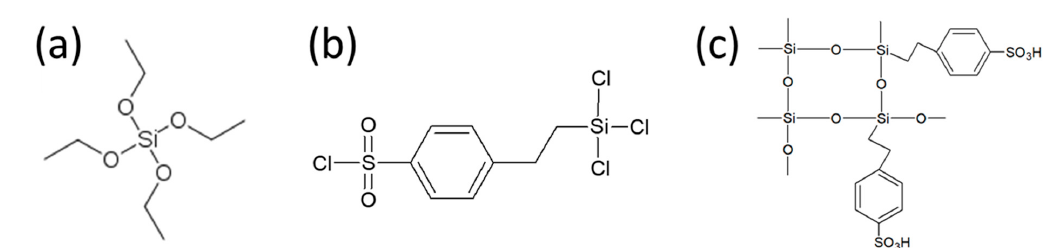
Figure 1. Silica precursors used in this study: ( a ) TEOS (tetraethyl orthosilicate), and ( b ) CSPTC (2-(4-chlorosulfonylphenyl)ethyltrichlorosilane). The sulfonated silica network after sol-gel hydrolysis and polycondensation is shown in ( c ).